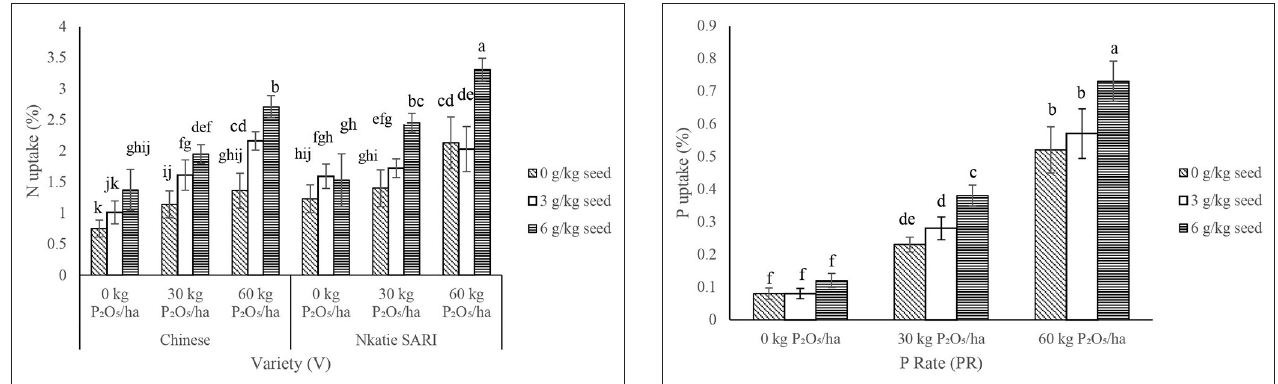
FIGURE 9 | Interactive effect of P-rate (PR) and inoculant rate (IR) on P uptake of groundnut grown in Haplic Lixisols of northern Ghana. Bars with different letters (in horizontal direction) show significantly different means. Error bars represent standard error of